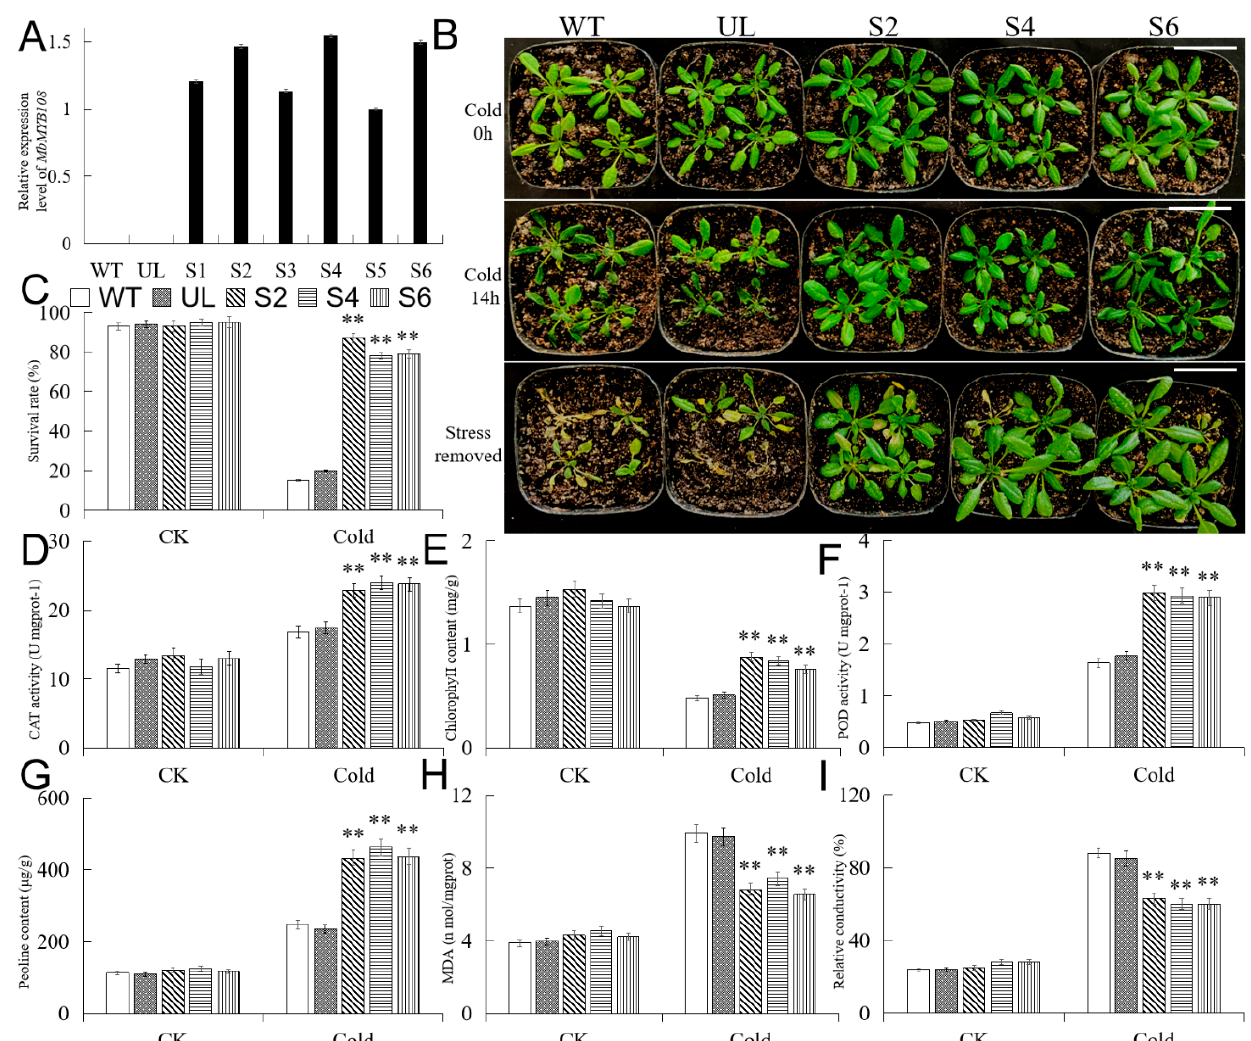
Figure 5. Overexpression of MbMYB108 in Arabidopsis thaliana improved cold tolerance. ( A ) Trans- genic A. thaliana qPCR validation. ( B ) Phenotypic map of each line (WT, UL, S2, S4, and S6) of A. thaliana under CK (Cold 0 h), cold stress (Cold 14 h), and recovery conditions (stress removed). Scale bar corresponds to 4 cm. ( C ) The survival rates of each line (WT, UL, S2, S4, and S6) of A. thaliana under CK and cold stress. ( D ) Catalase (CAT) activity. ( E ) Chlorophyll content. ( F ) Peroxidase (POD) activity. ( G ) Proline content. ( H ) Malondialdehyde (MDA) content. ( I ) Relative conductivity. Asterisks above the error bars indicate extremely significant differences between transgenic (S2, S4, S6) and WT A. thaliana (** p ≤ 0.01). The level of each index in the WT line was used as a control.